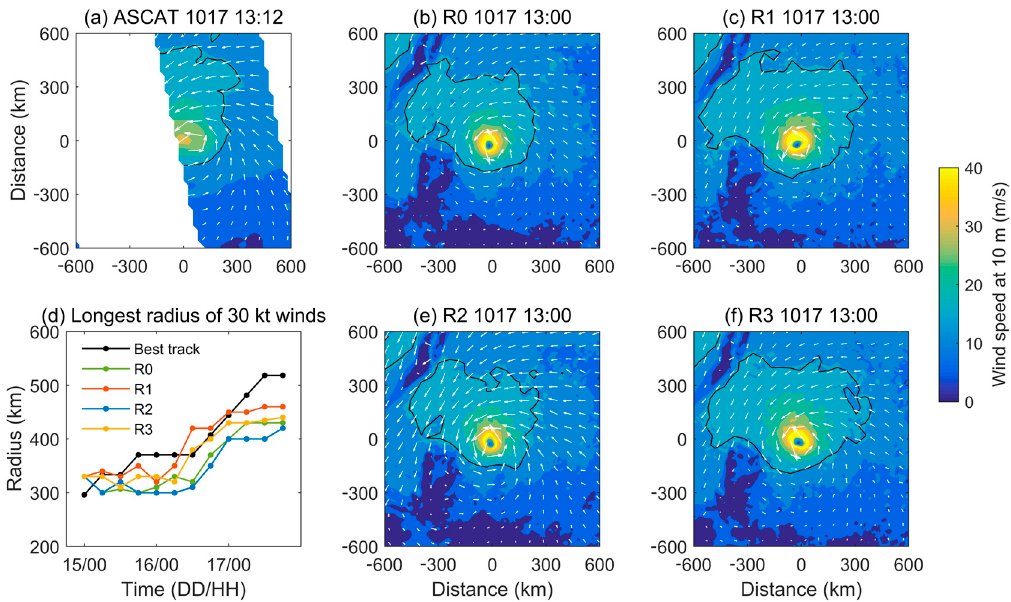
Figure 5. Megi wind speeds at 10 m above the sea surface. ( a ) ASCAT wind speed observations at 13:12 UTC on 17 October 2010; ( b , c , e , f ) simulated wind speeds from four different numerical experiments at 13:00 UTC on 17 October 2010; ( d ) longest radius of 30 kt (15.4 m/s) from JMA best track data and four different numerical experiments at 6-hourly intervals from 00:00 UTC 15 October through 18:00 UTC 17 October 2010. Black lines in panels ( a – c , e , f ) represent the 15.4 m/s isotach. See Table 1 for details of the different numerical experiments.